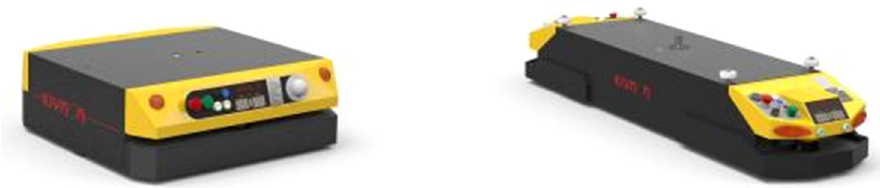
Figure 1: Example of an automatic truck used in internal logistics [ 13,14 ]